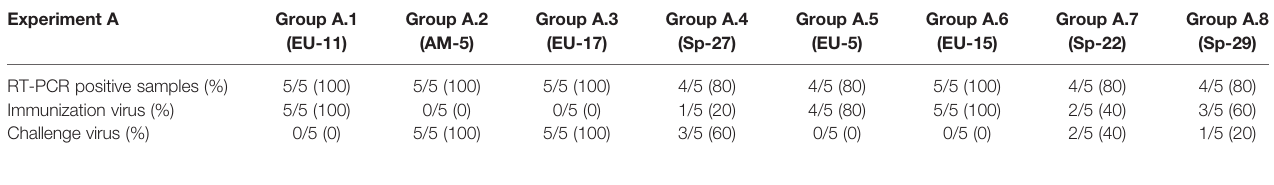
TABLE 5.1 | Results of PRRSV RT-PCR and PRRSV isolate identi fi cation by sequencing from tonsils collected at necropsy from pigs in Experiment A. Experiment A